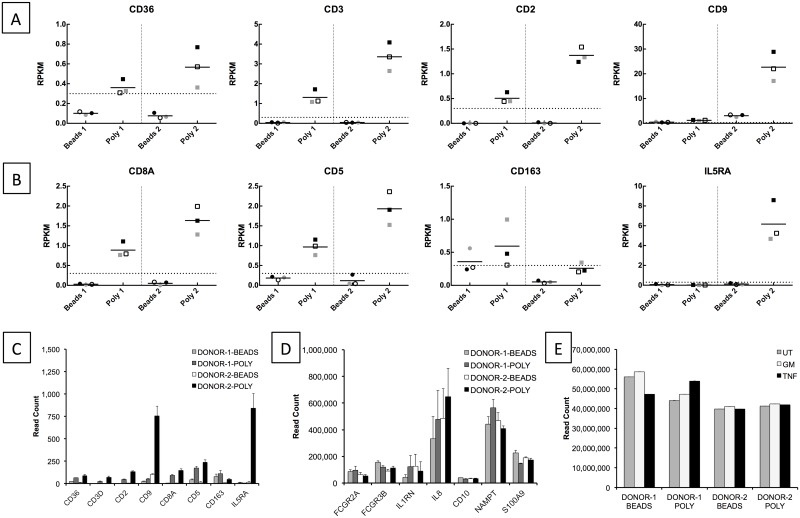
Expression levels of non-neutrophil genes in neutrophil preparations.RPKM values for non-neutrophil genes of the antigen targets in the StemCell magnetic bead negative selection isolation kit (A) and (B) non-neutrophil specific genes associated with T and B cells, monocytes, and eosinophils. Neutrophils were either isolated by negative selection (Bead, circle) or by Polymorphprep (Poly, square) from Donor 1 (1) and Donor 2 (2). Neutrophils were treated with 5 ng/mL GM-CSF (shaded grey), 10ng/mL TNFα (shaded white) or untreated (shaded black) for 1h. Horizontal dotted lines represent RPKM expression threshold of 0.3. Horizontal bars represent mean value. (C) The number of read fragments mapping to non-neutrophil genes and (D) neutrophil-specific genes in each library. Data is shown as the average (±SEM) across three treatment conditions (UT, TNFα, GM-CSF) for each Donor and each isolation protocol. (E) The number of mapped reads in each dataset.